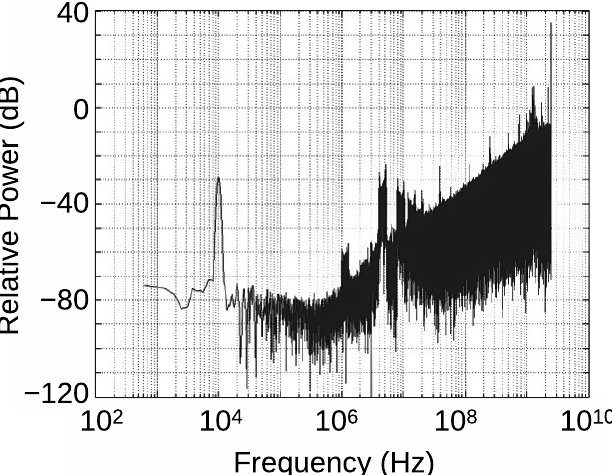
Figure 6. An example of the output spectrum of the delta-sigma modulation microphone